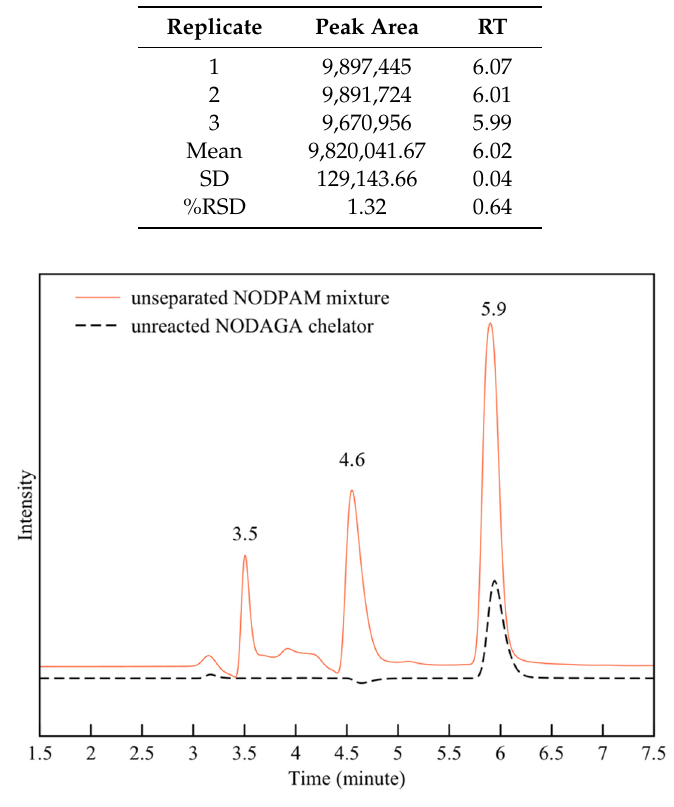
Figure 6. The identification of the unreacted NODAGA chelator RP-HPLC chromatogram from the unseparated NODPAM mixture (UV 220 nm, 0.1% TFA + water, flow rate: 0.5 mL/min).